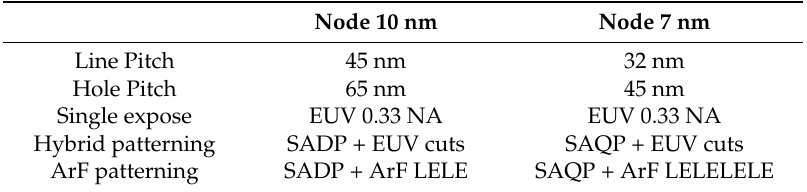
Table 1. Critical pitches in logic M1 (the first metal layer at back end of the line (BEOL), specially in copper interconnect process) and possible patterning methods (LE: litho + Etch multiple